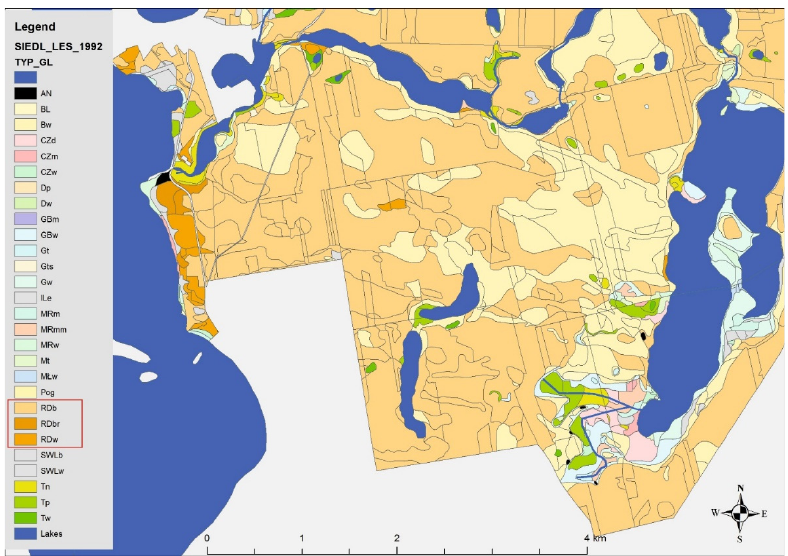
Figure 10. Classification of the soils of the selected area of the BTNP (according to http://gis.pnbt.com.pl/, accessed on 27 July 2022) on the basis of traditional soil pits. In the legend, rusty soils are marked with a red rectangle, differentiating into three subtypes: rusty podzolic (RDb), typical rusty (RDw), and brunic rusty (RDbr). Podzolic soils (BL and Bw) also have a significant share on the map .